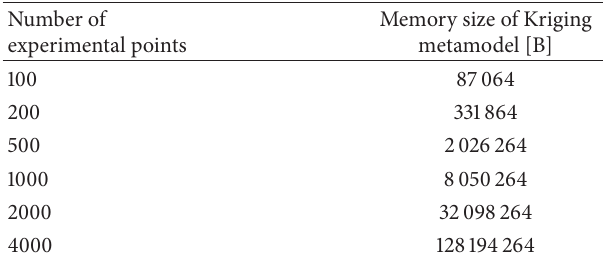
Table 2: Memory size of Kriging metamodel with respect to the number of experimental points.